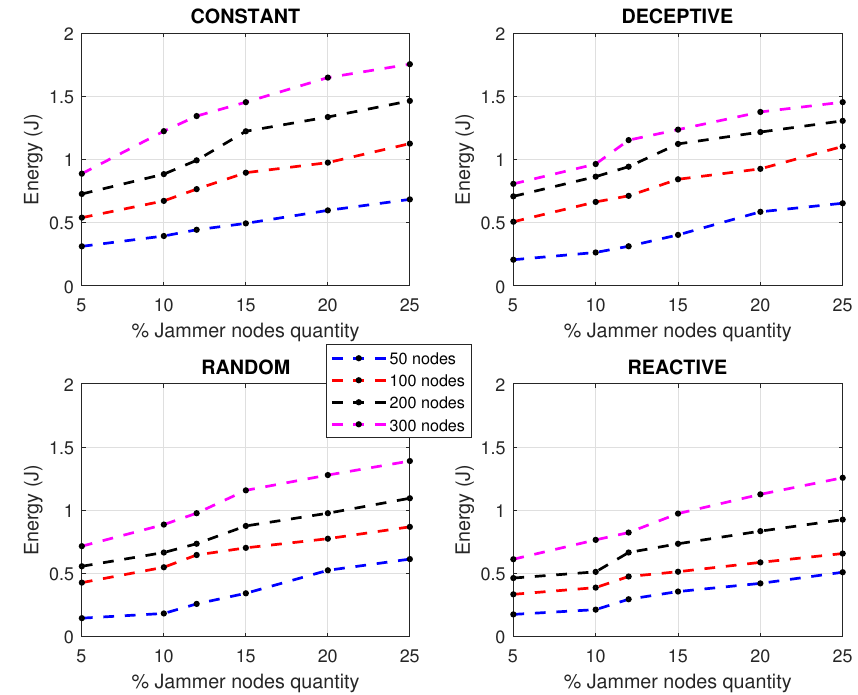
Figure 7. Types of jamming varying the number of